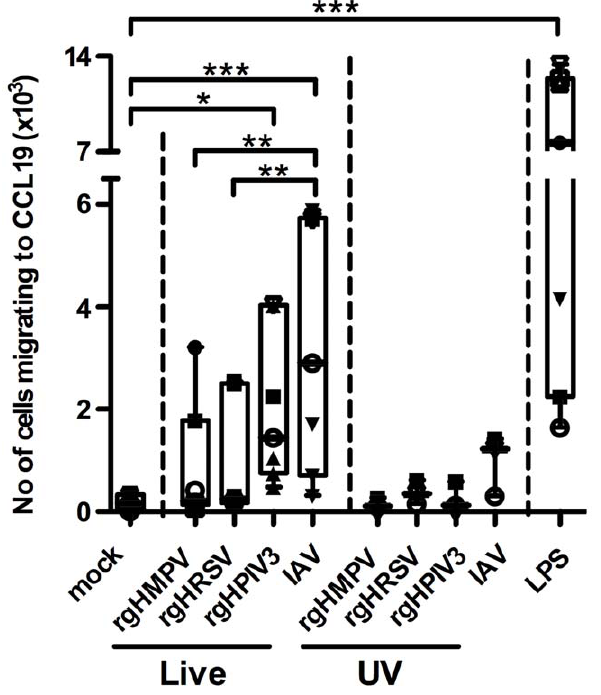
Figure 3. MDDC stimulated with IAV migrate more efficiently to a CCL19 concentration gradient than HMPV- or HRSV- stimulated MDDC. Immature MDDC were stimulated with LPS or infected with rgHMPV, rgHRSV, rgHPIV3, IAV, or with their